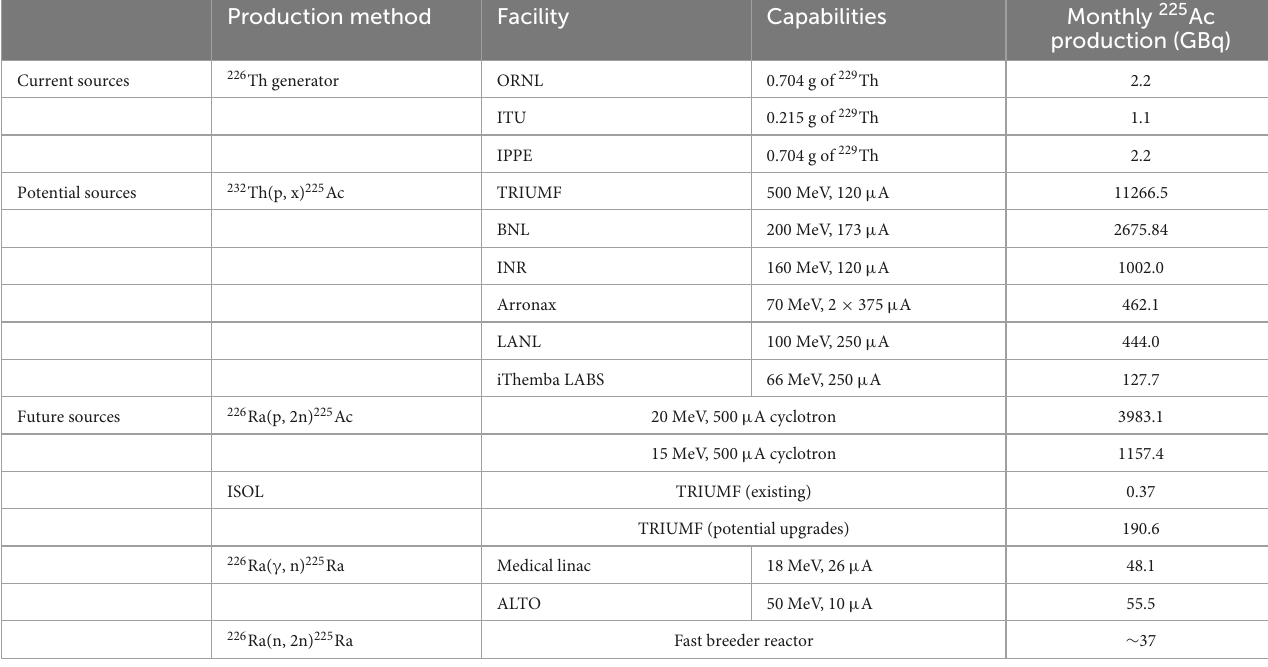
TABLE 4 Summary of current and potential future capacity for key 225 Ac production